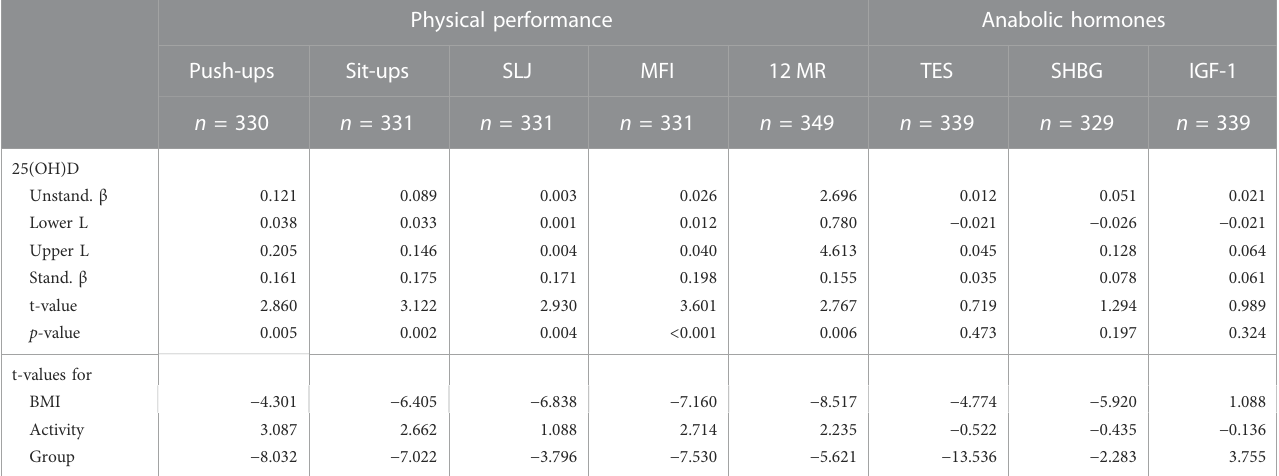
TABLE 2 Associations of serum 25(OH)D physical performance, and anabolic hormones using linear regression analysis adjusting analysis by group, body mass index, and exercise activity. Differences between groups were tested using Linear Regression analysis. Results are shown using unstandardized beta (Unstand. β ) with lower (Lower L) and upper limit (Upper L) of 95% con fi dence interval, standardized beta (Stand. β ), and p -values. Push-ups in 1 minute, Sit-ups in 1 min, SLJ = standing long jump, MFI = muscular fi tness index (push-up, sit-up, and SLJ combined), 12 MR = 12-min running test, TES = testosterone, SHBG = sex hormone binding globulin,